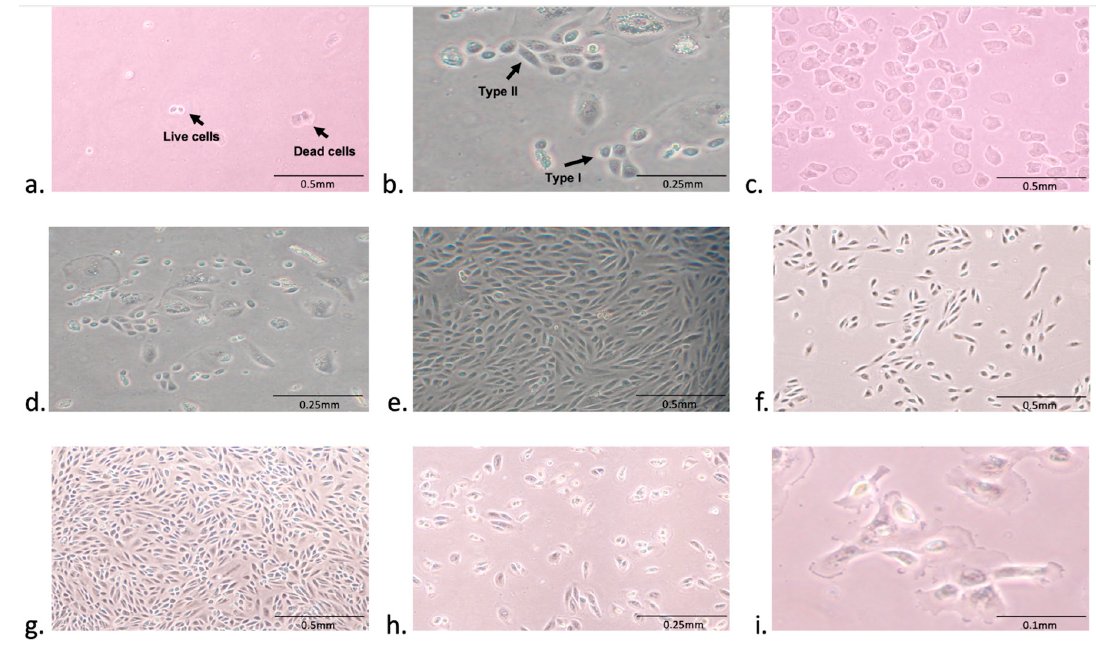
Figure 2. Isolation and expansion of urine-derived epithelial cells. ( a ) A representation of living and dead cells in urine samples. ( b ) Urinary cell morphologies: Type I shows a smooth-edged contour, and Type II, have cobblestone-like cell morphology with random arrangements. ( c ) Squamous cells in the urine sample of female individuals. ( d ) Epithelial cell colonies appear within 2–3 weeks after plating. ( e ) 70–80% cell confluency. ( f ) Expansion of epithelial cells at P1 in the T-2 flask. ( g ) 80% cell confluency in a T-25 flask. ( h ) The number of cells decreased after four passages. ( i ) The slow growth of epithelial cells at later passages. 10 × magnification was used for image ( a , c , e – g ) while ( b , d , h ) have been captured at 20 × magnification, the 40 × magnification was used for the image ( i